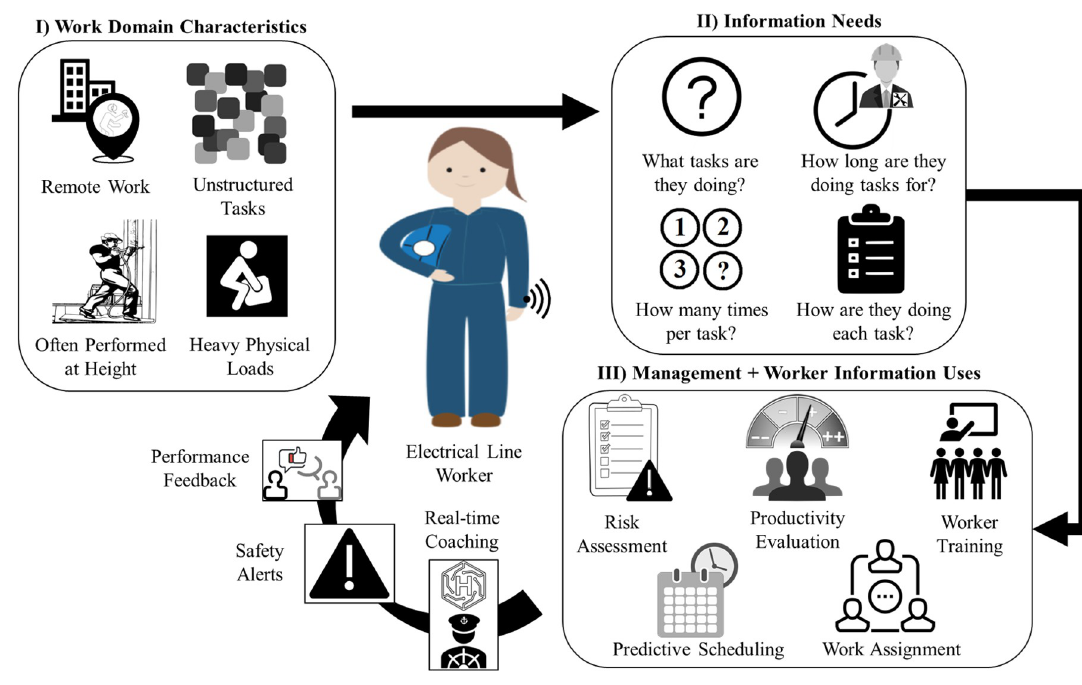
Fig 1. Use of IoT for safety